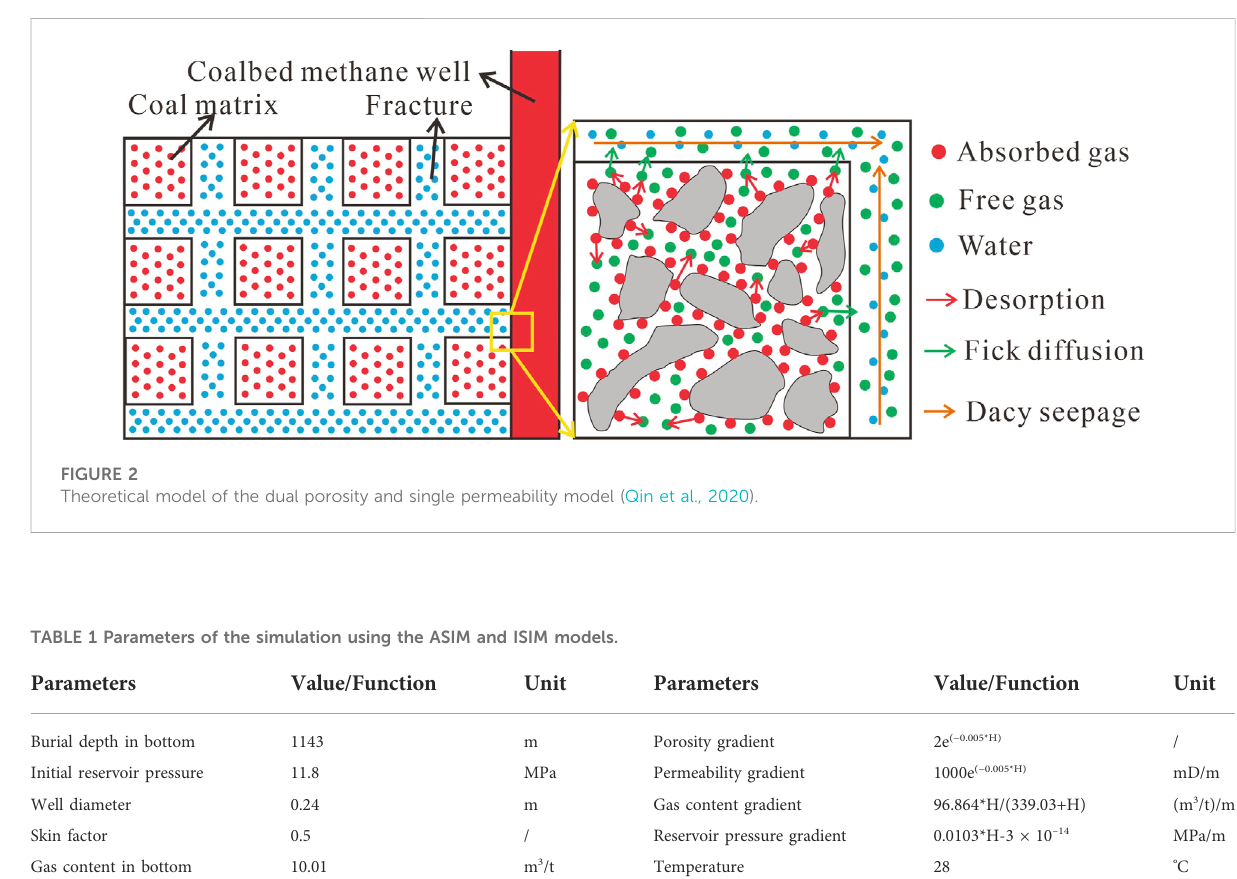
(Figure 2). In the process of CBM production simulation of